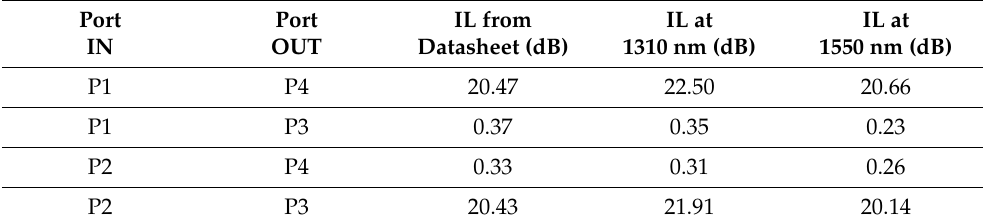
Table 3. Insertion loss of the coupler 99:1.